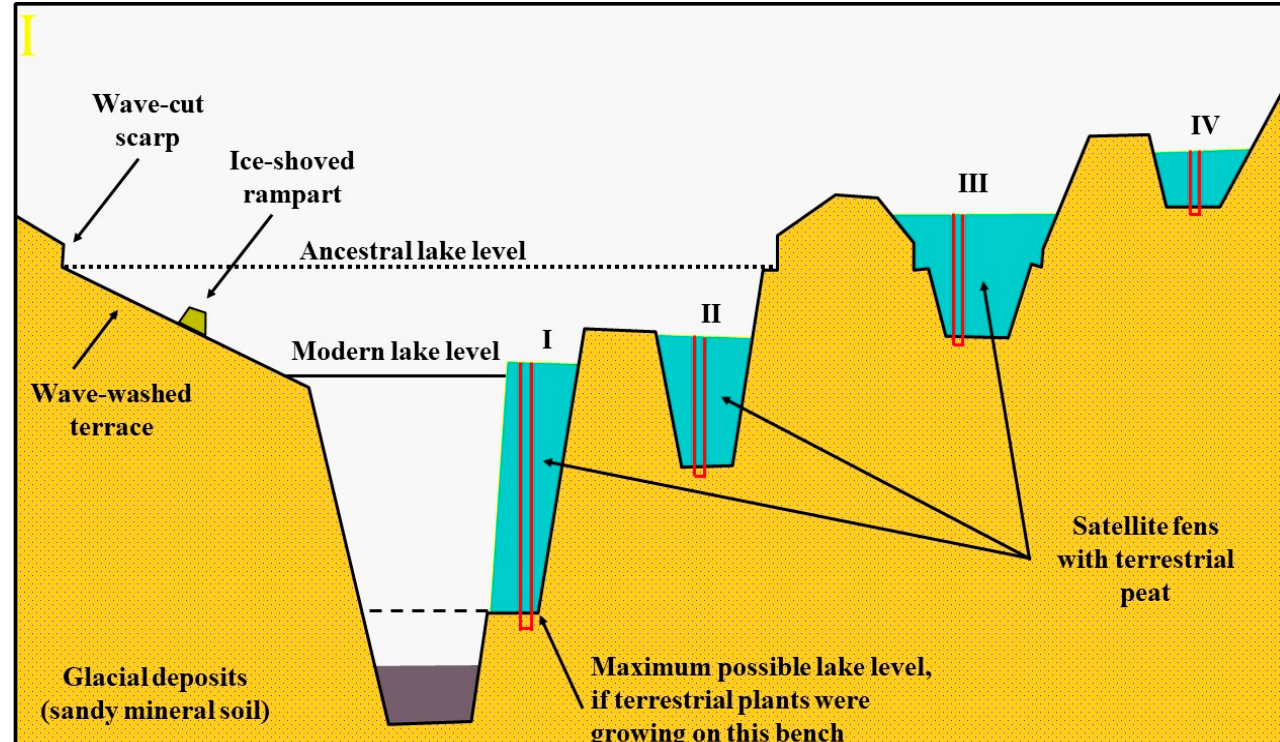
Figure 3. Conceptual model for estimating paleo-lake levels from the botanical stratigraphy of satellite-fen peats, ice-shoved ramparts (ISRs), and wave-cut scarps (WCSs). WCSs mark late-glacial high stands, and wave-washed terraces are formed as lake levels recede from these early high stands. ISRs provide maximum-limiting estimates of late-Holocene high stands. Fens I–III lie within an ancestral lake basin and were hydrologically connected at higher stands; only Fens I and II are shown as connected. Fen IV was never connected to the lake; its peat record is a control, so to speak, governed by climatic and autogenic succession processes and not by the lake level trajectory. Fen I is directly hydrologically coupled to the lake and provides the strongest record of lake level